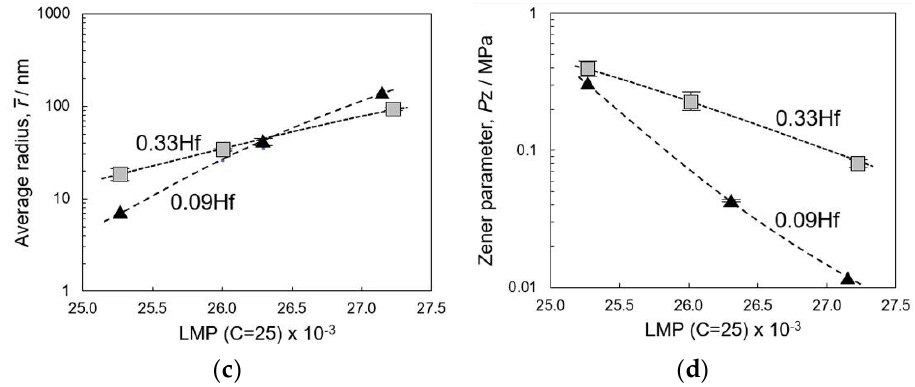
Figure 12. Measured number density ( a ) and area fraction ( b ) of Laves phase particles and calculated mean radius ( c ) and Zener pinning force ( d ) of the particles taken from the creep-interrupted and creep-ruptured samples, as plotted against their Larson-Miller parameter (LMP) values.